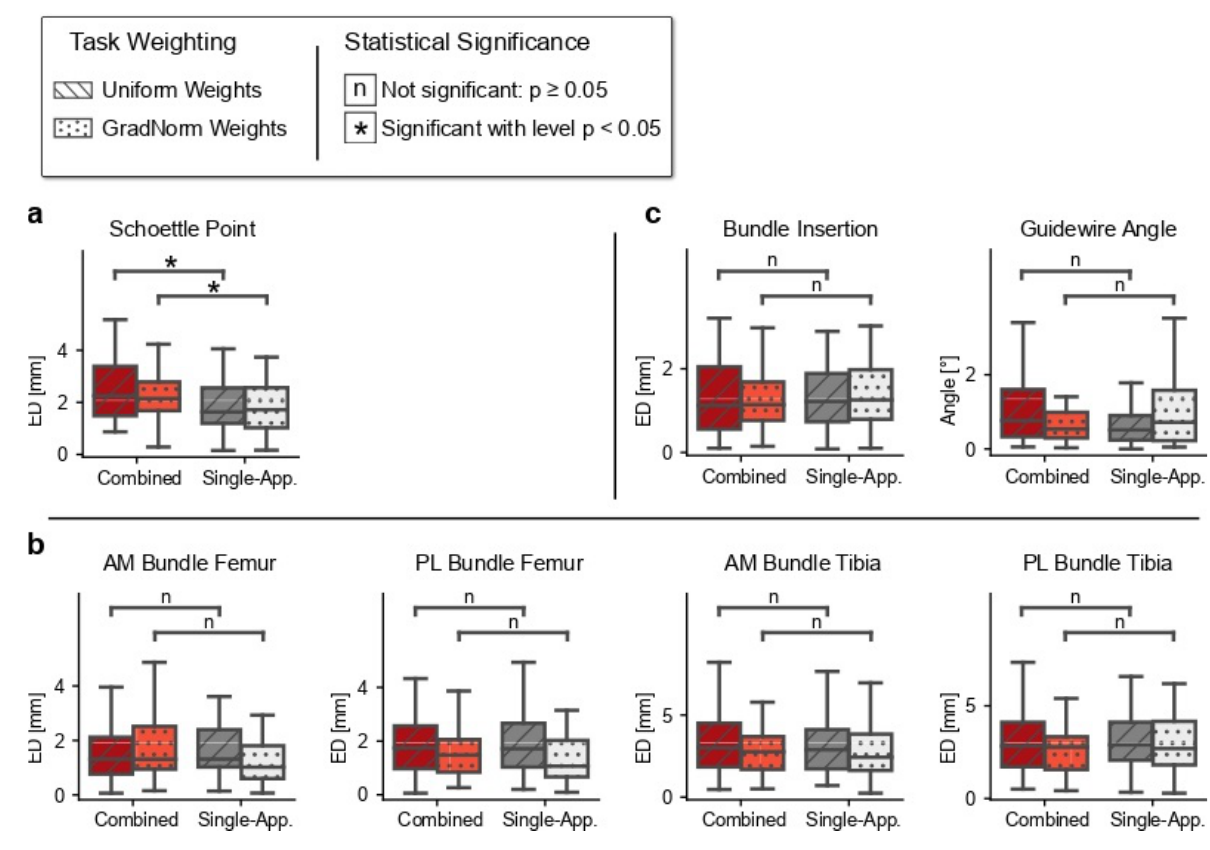
Figure 7. Comparison between single- and multi-application model performance on the test set. ( a ), MPFL. ( b ), ACL. ( c ), PCL. For each boxplot and pairing, we tested statistical significance with a two-sided Mann–Whitney U rank test ((n) not significant: p ≥ 0.05, (*) significant: p <